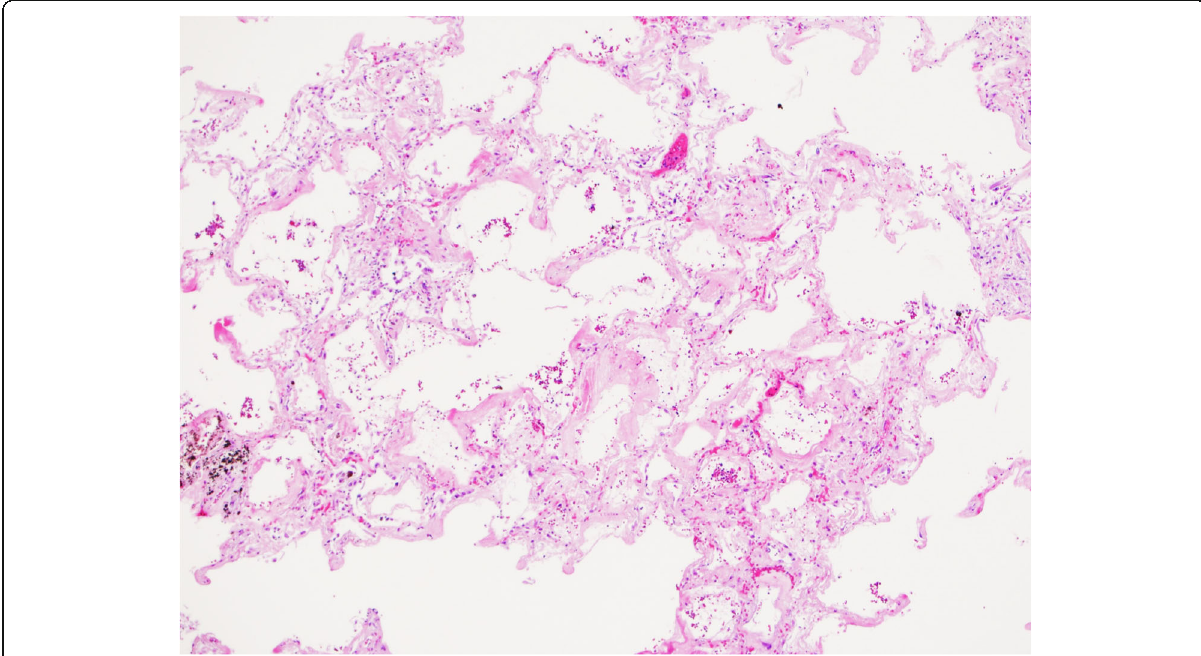
Fig. 5 Microscopic examination of the lung from the autopsy shows various stages of diffuse alveolar damage, including hyaline membrane and fibroblast proliferation (hematoxylin and eosin, original magnification